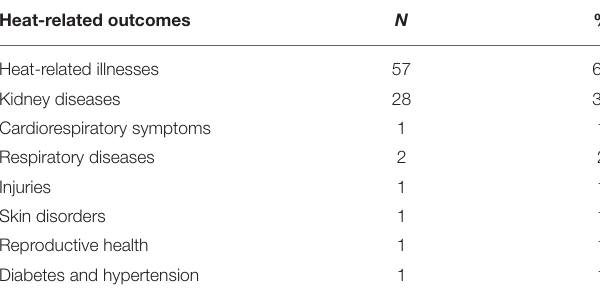
TABLE 2 | Heat-related health outcomes of included